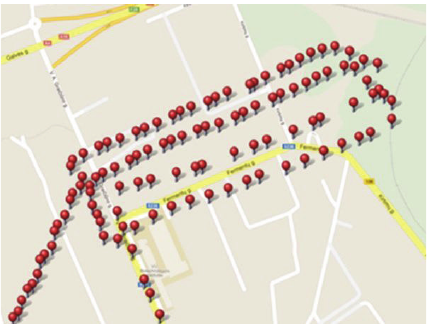
Figure 3: Flight configurations in